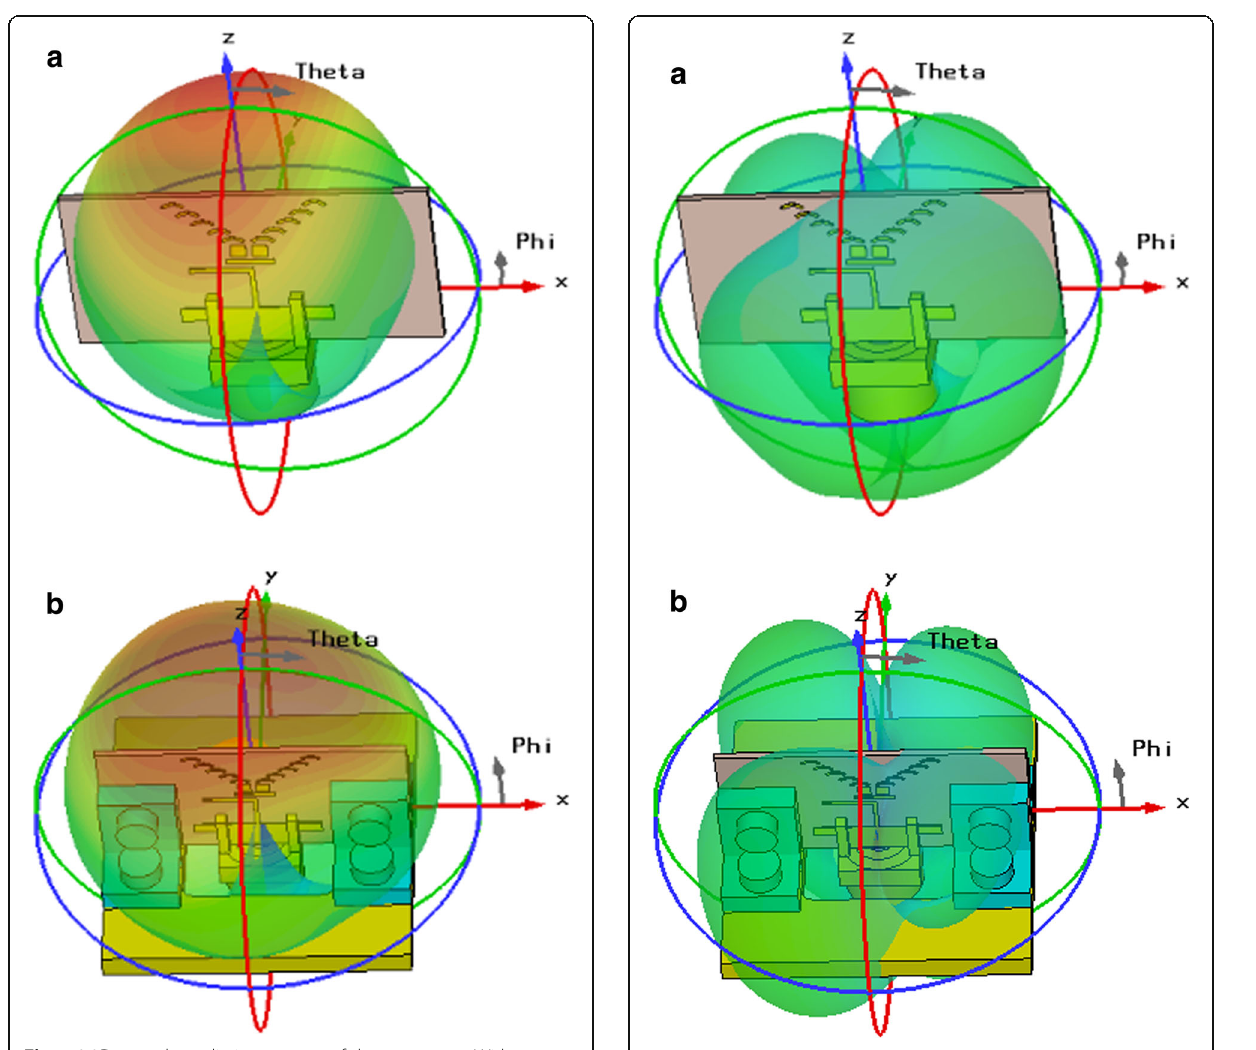
Fig. 17 3D cross-polar radiation pattern of the antenna. a Without backplate. b With backplate